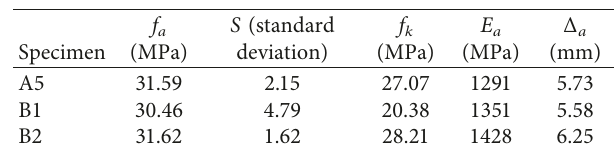
Table 4: Mechanical parameters of specimens with different fiber